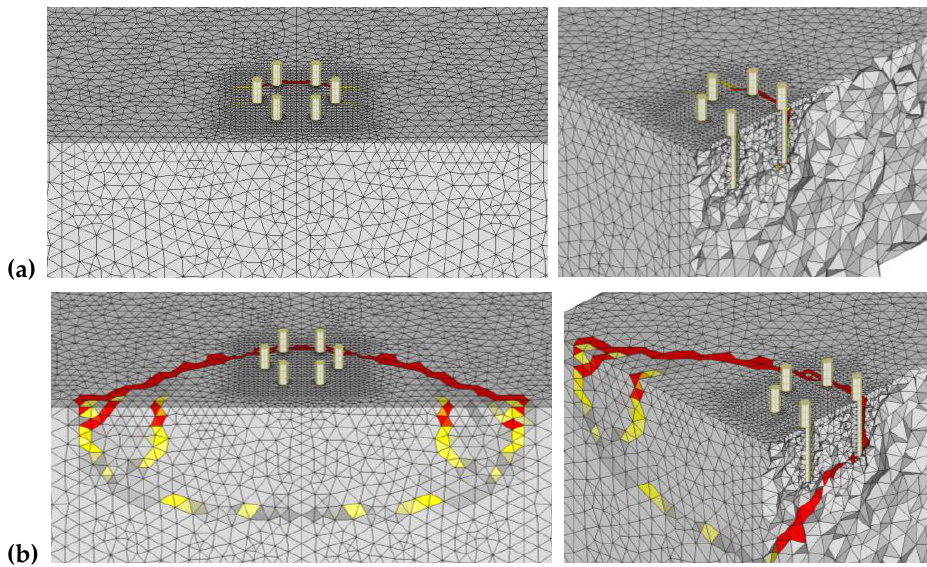
Figure 12. Crack pattern obtained from numerical analysis for Group Hex-A ( a ) at peak load, and ( b ) Crack pattern in the post-peak phase.